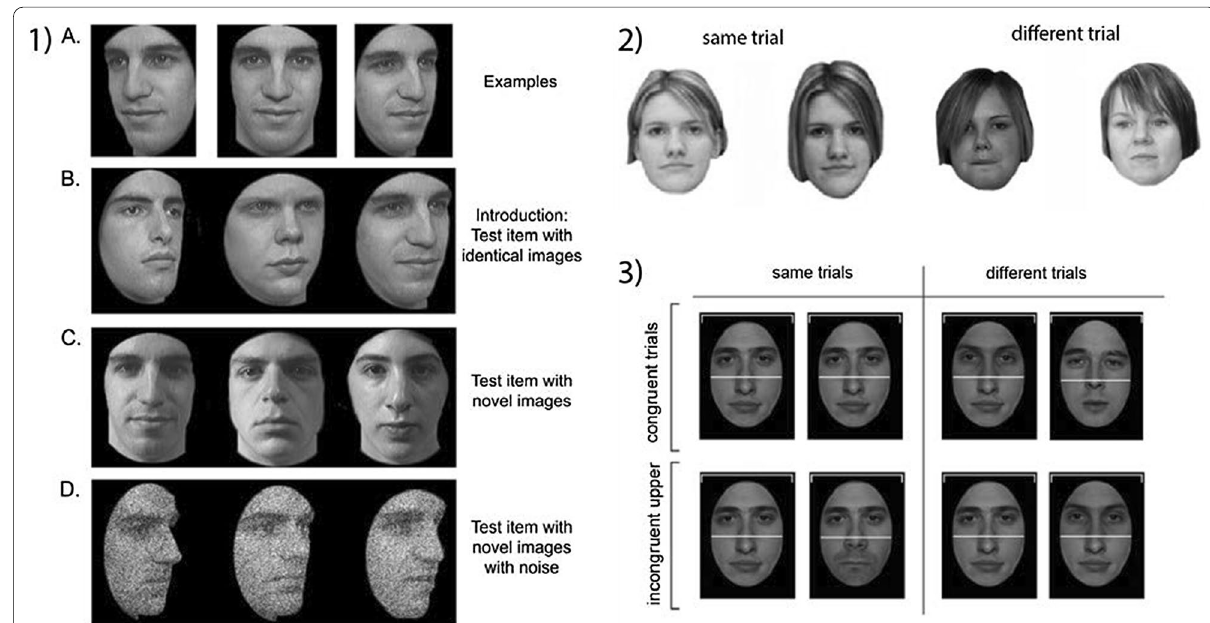
Fig. 1 (1) The Cambridge Face Memory Task (CFMT; Reproduced with permission from Duchaine & Nakayama, 2006). A At learning, six target faces are shown for memorization followed by test trials where the target face has to be identified among two distractors. Recognition of target faces is tested in three stages with increasing difficulty. B Learned faces are shown in the same viewpoint as learning. C Learned faces are shown in a different viewpoint than at learning. D Learned faces shown in different viewpoints and with noise added to the images. (2) The Glasgow Face Matching Task (GFMT; The individuals shown in the figure have given written informed consent to publish these images). Participants are asked to determine the two simultaneously presented faces are matching (yes/no). Presentation time is self‑paced. (3) The complete composite test. Examples of same and different congruent and incongruent trials. Participants indicate whether the identity of the relevant half (top or bottom) is same or different. In the examples, the relevant half is always the top, as indicated by the white horizontal cue. In congruent same trials, the identity of the relevant and irrelevant halves of two sequentially presented faces is the same. In congruent different trials, the identity of the relevant and irrelevant halves of two sequentially presented faces is different. In incongruent same trials, the identity of the relevant halves of two sequentially presented faces is the same, but the identity of the two irrelevant face halves is different. In incongruent different trials, the identity of the relevant halves of two sequentially presented faces is different, but the identity of the two irrelevant face halves is the same. Because of automatic holistic processing of faces, the presence of irrelevant face features interferes with matching of the relevant halves, leading to poorer performance